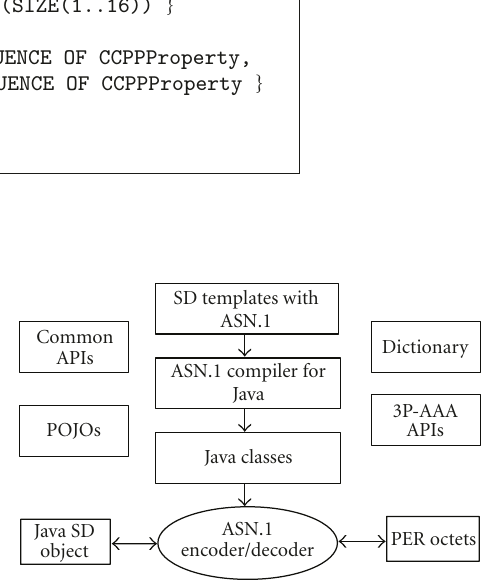
Figure 2: The ASN.1-PER encoding/decoding of